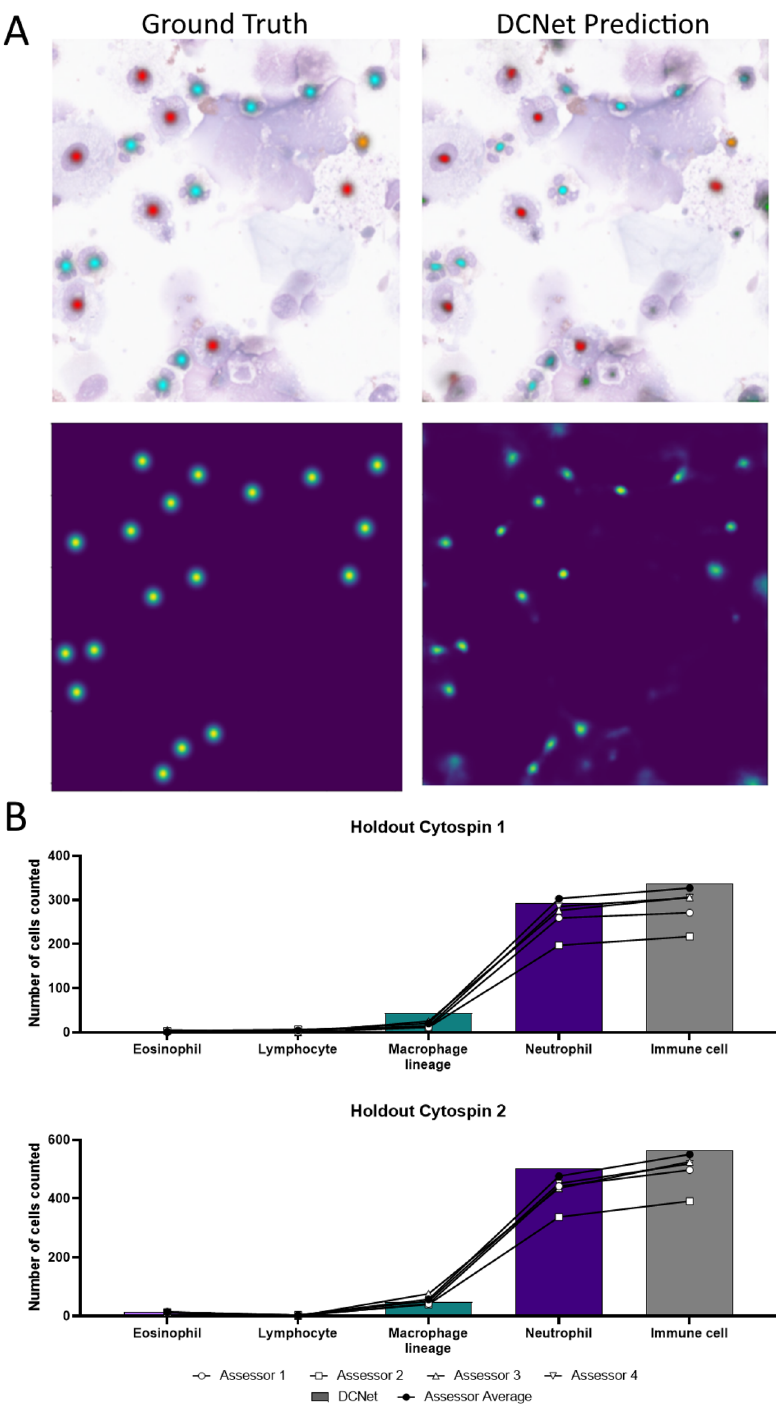
Figure 5. DCNet matches human assessors at total differential cell outcomes on unseen images. On two holdout cytospins not included in training, DCNet performed well in classification and localisation as indicated by ( A ) representative mask and heatmap images respectively. ( B ) DCNet also concurred with human annotation assessors on the final immune differential cell count for both holdout cytopsins. Data generated from 40 tile images per